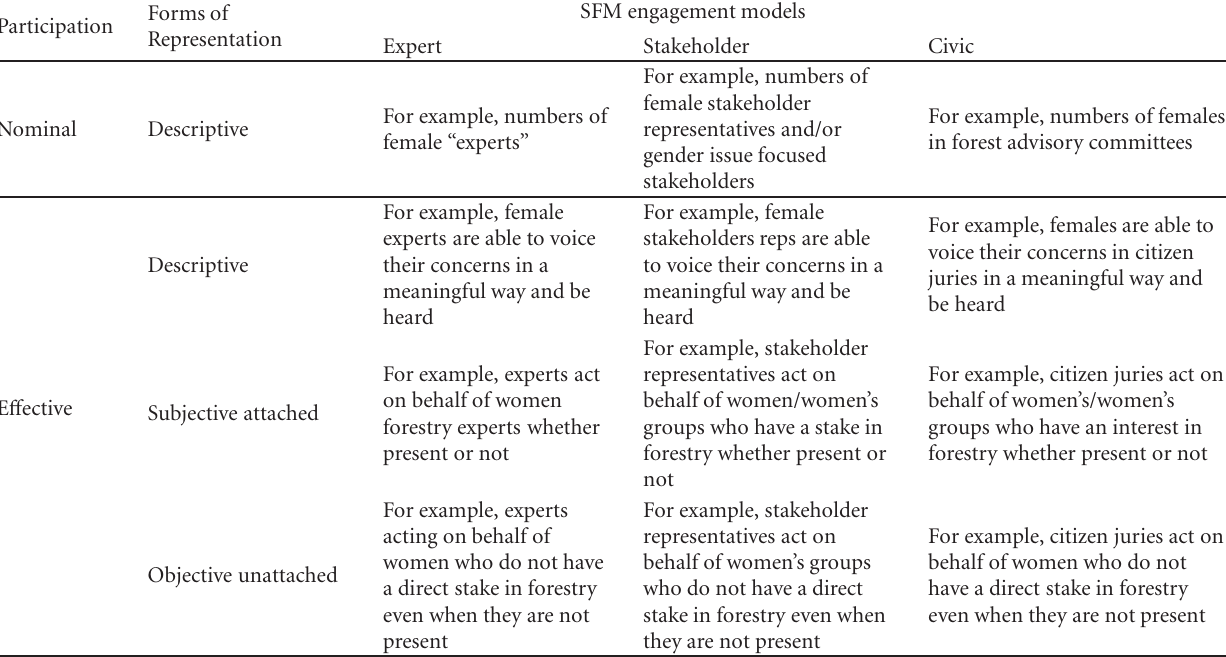
Table 1: Measures to assess female participation and representation in SFM engagement models.